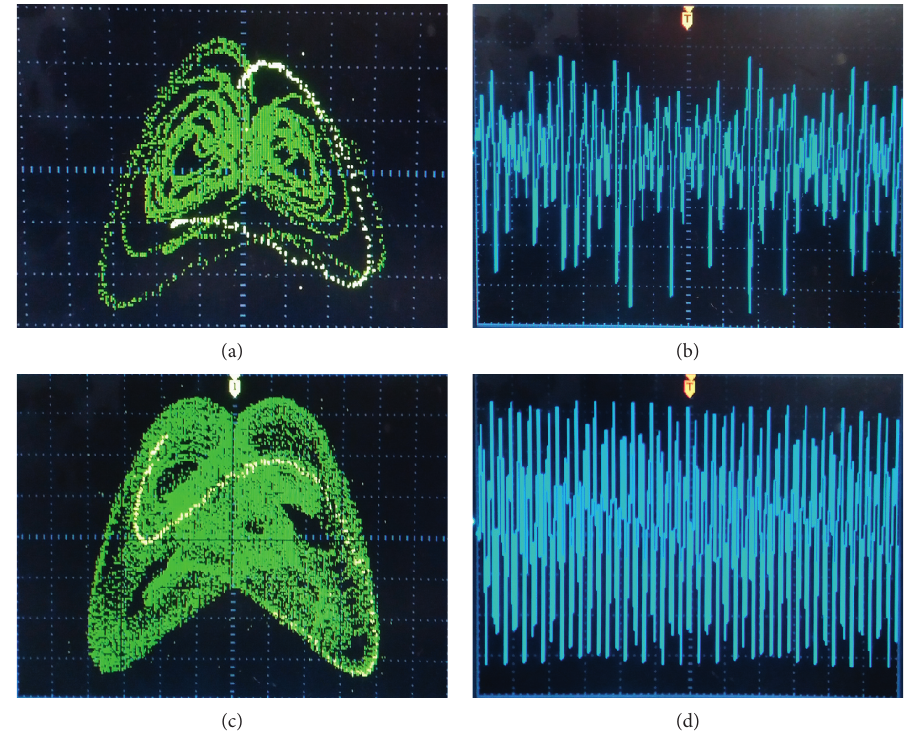
Figure 19: Chaotic and quasiperiodic attractors from the microcontroller-based implementation of system